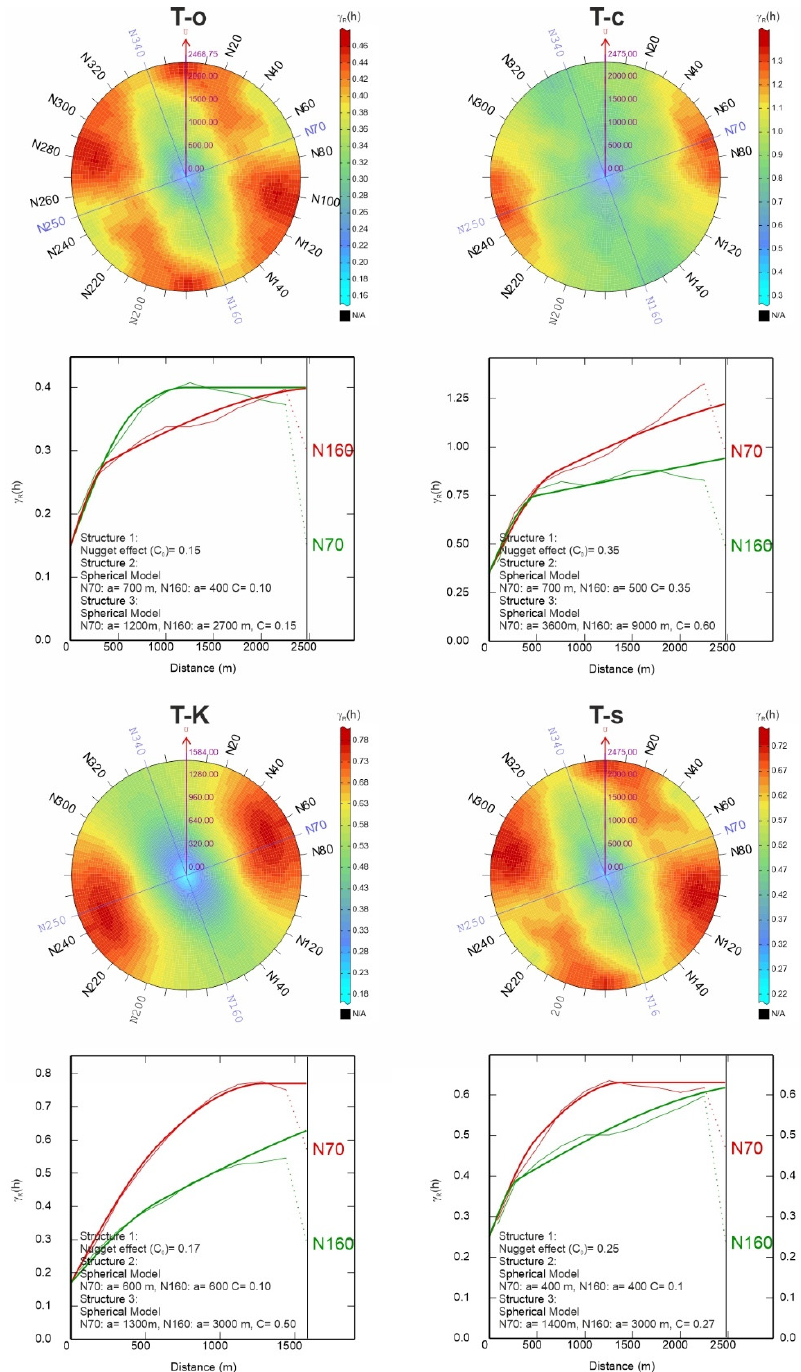
Figure 10. Maps of relative directional variograms of deposit thickness and variograms for the directions of minimum (green lines) and maximum (red lines) variability approximated by theoretical models (the anisotropy direction were measured in degrees clock-wise from the North; T-o—thick-